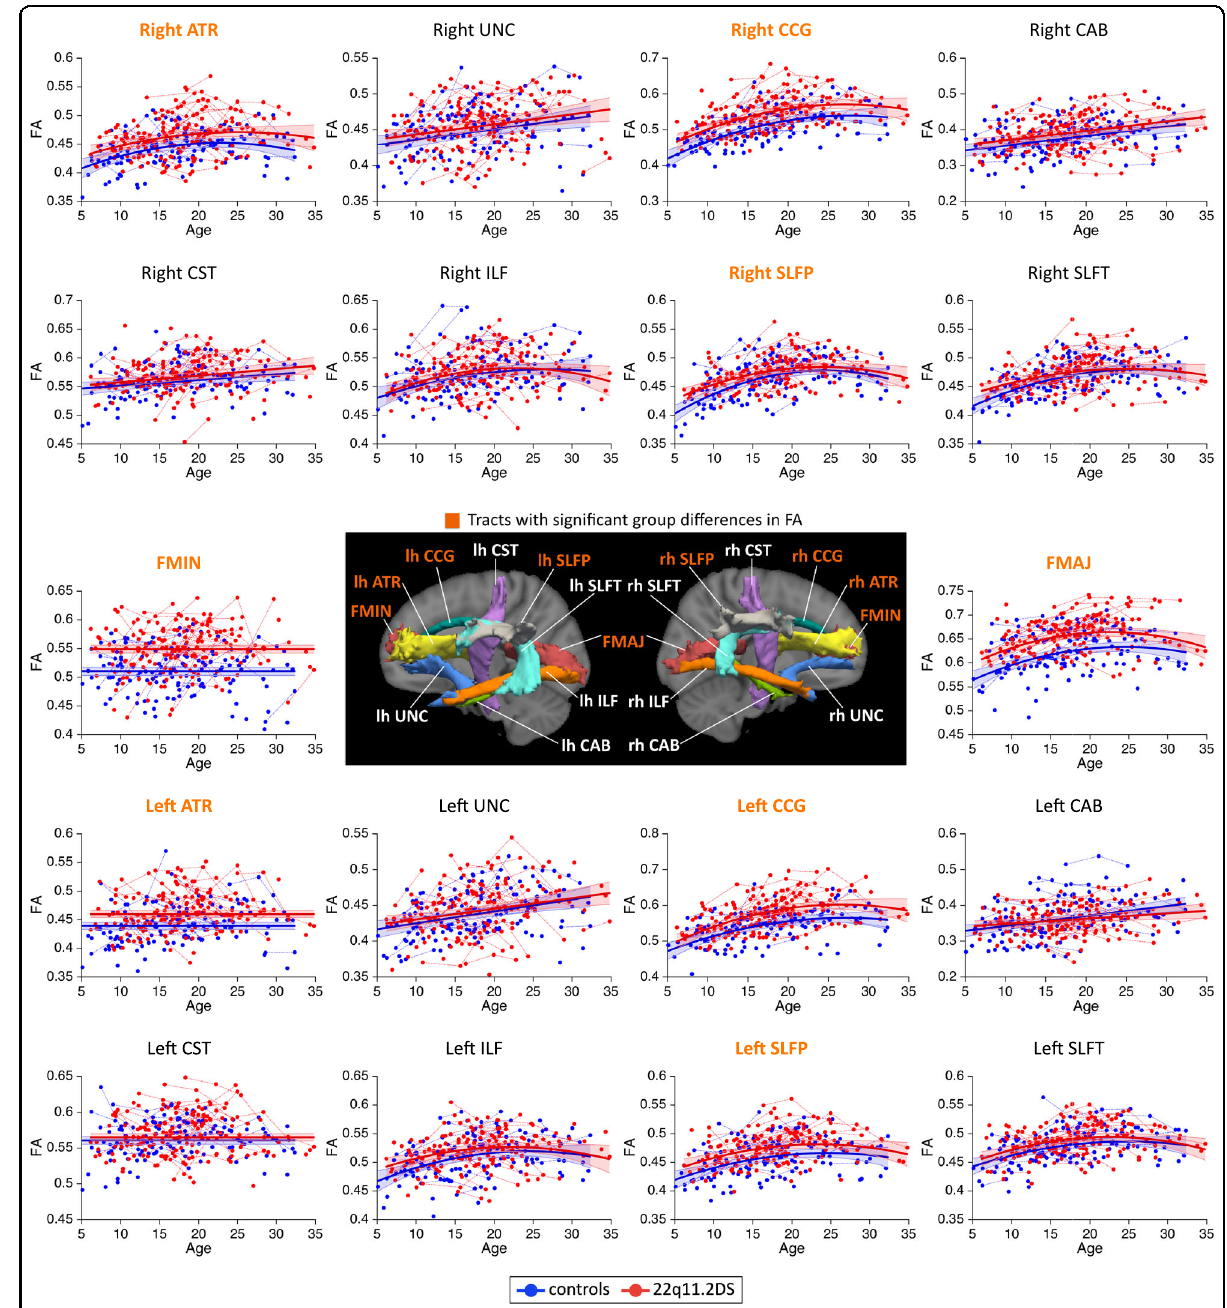
Fig. 4 Developmental trajectories of fractional anisotropy (FA) in patients with 22q11.2DS and controls. FA metrics followed increasing quadratic or linear developmental curves in 22q11.2DS (red) and controls (blue). Age × group interaction effects were again not signi fi cant, revealing parallel trajectories in both groups. Group differences were visible in a number of tracts, where FA was systematically increased in 22q11.2DS. Tracts with signi fi cant group differences are highlighted in orange in plot titles and in the central fi gure. The signi fi cance threshold was set at p < 0.05. All results were corrected for multiple comparisons using the FDR method. lh left hemisphere, rh right hemisphere, FMAJ forceps major, FMIN forceps minor, ATR anterior thalamic radiation, CAB cingulum – angular bundle, CCG cingulum – cingulate bundle, CST corticospinal tract, ILF inferior longitudinal fasciculus, SLFP superior longitudinal fasciculus – parietal bundle, SLFT superior longitudinal fasciculus – temporal bundle, UNC uncinate